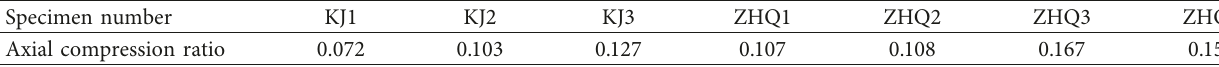
Table 4: Axial compression ratio of specimen.